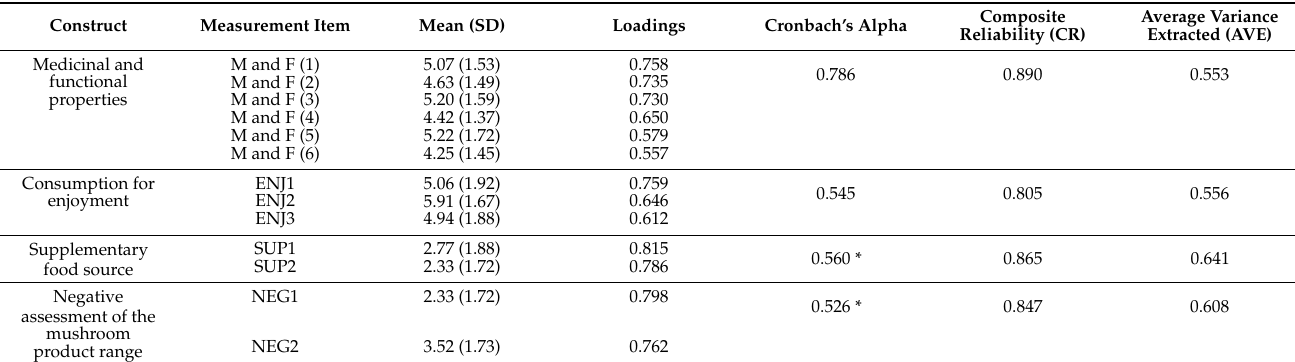
Table 5. Descriptive statistics of items and internal reliability and convergent validity of the latent variables based on the results of Exploratory factor analysis (N =